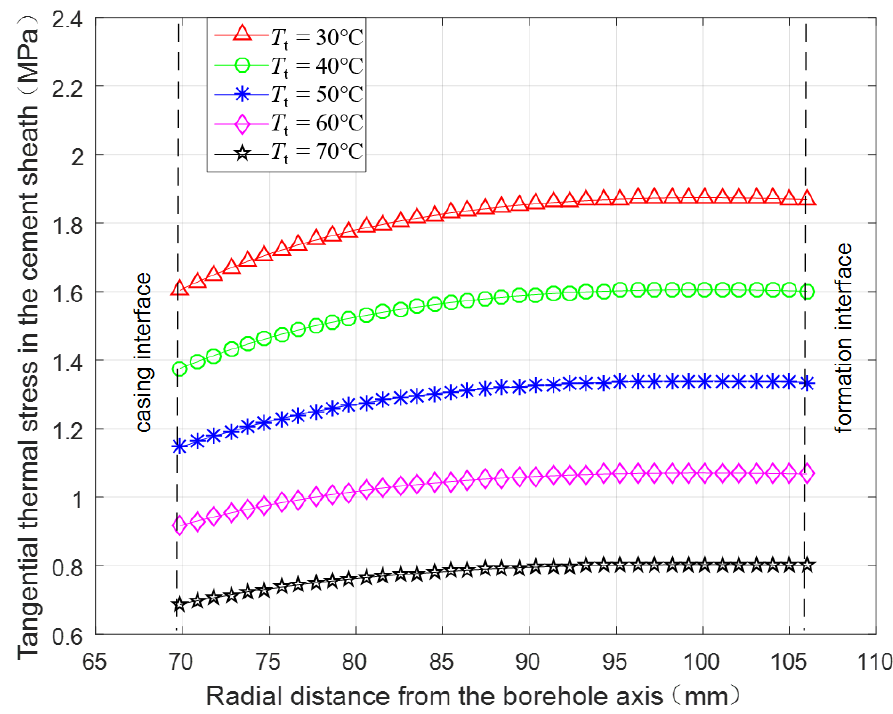
Figure 11. Radial distribution of the tangential thermal stress in the cement sheath under different wellbore temperatures after fracturing fluid injection.